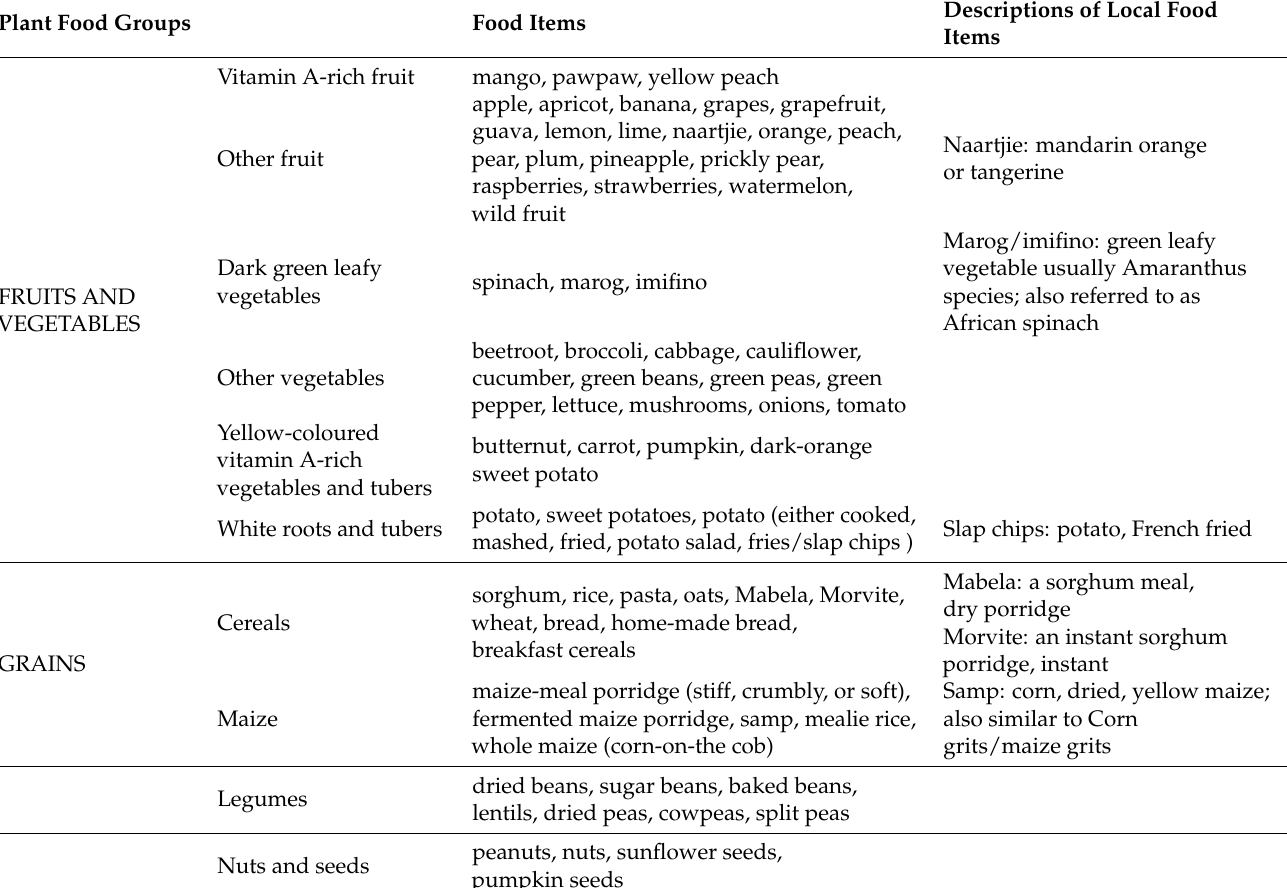
Table 1. List of healthy plant food groups and description of local food